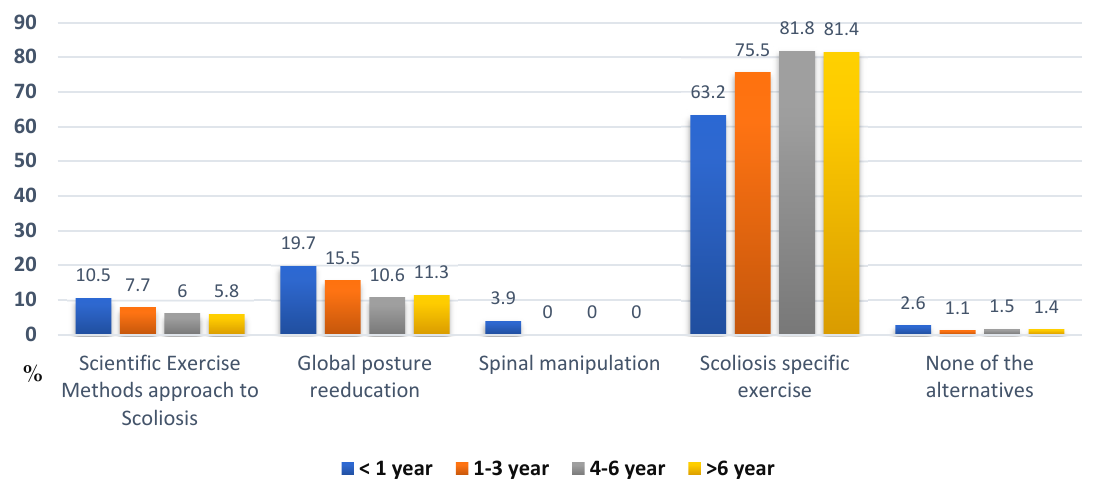
Figure 2. Percentual of participants opinion on the conservative method that would be recommended for the treatment of AIS.